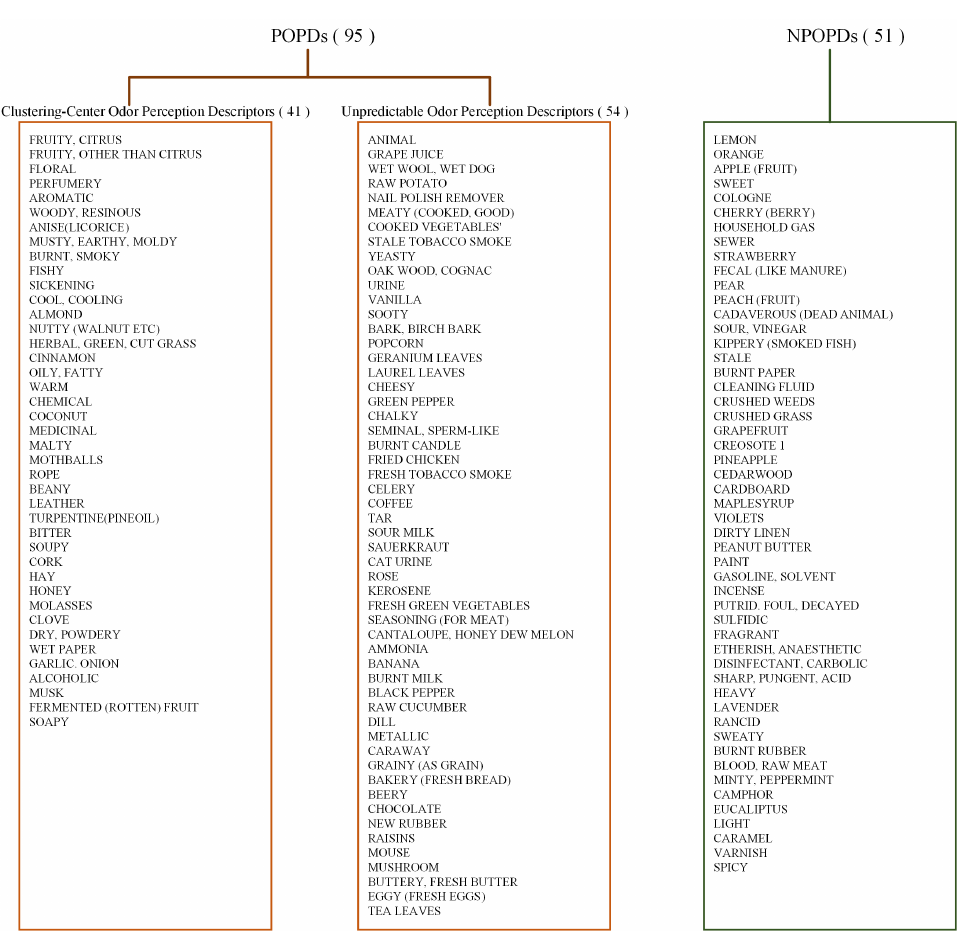
Figure 10. The results of the identification of POPDs and